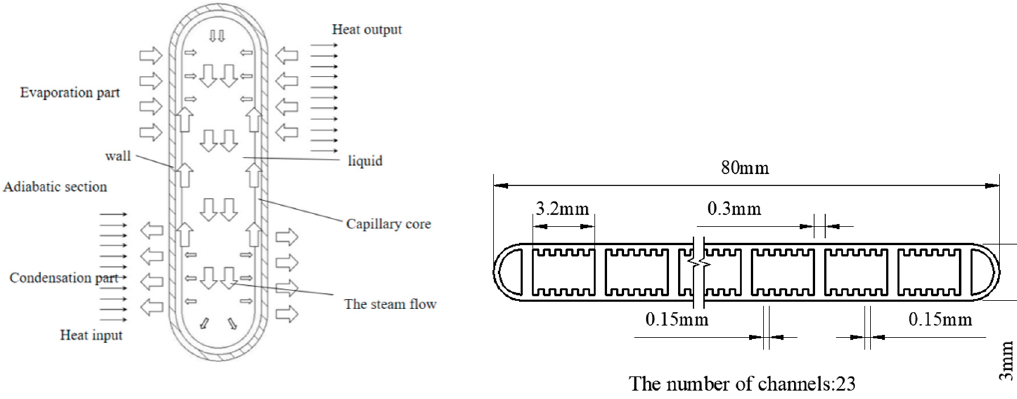
Figure 1. The operation principle and the internal dimensions of a microtube array